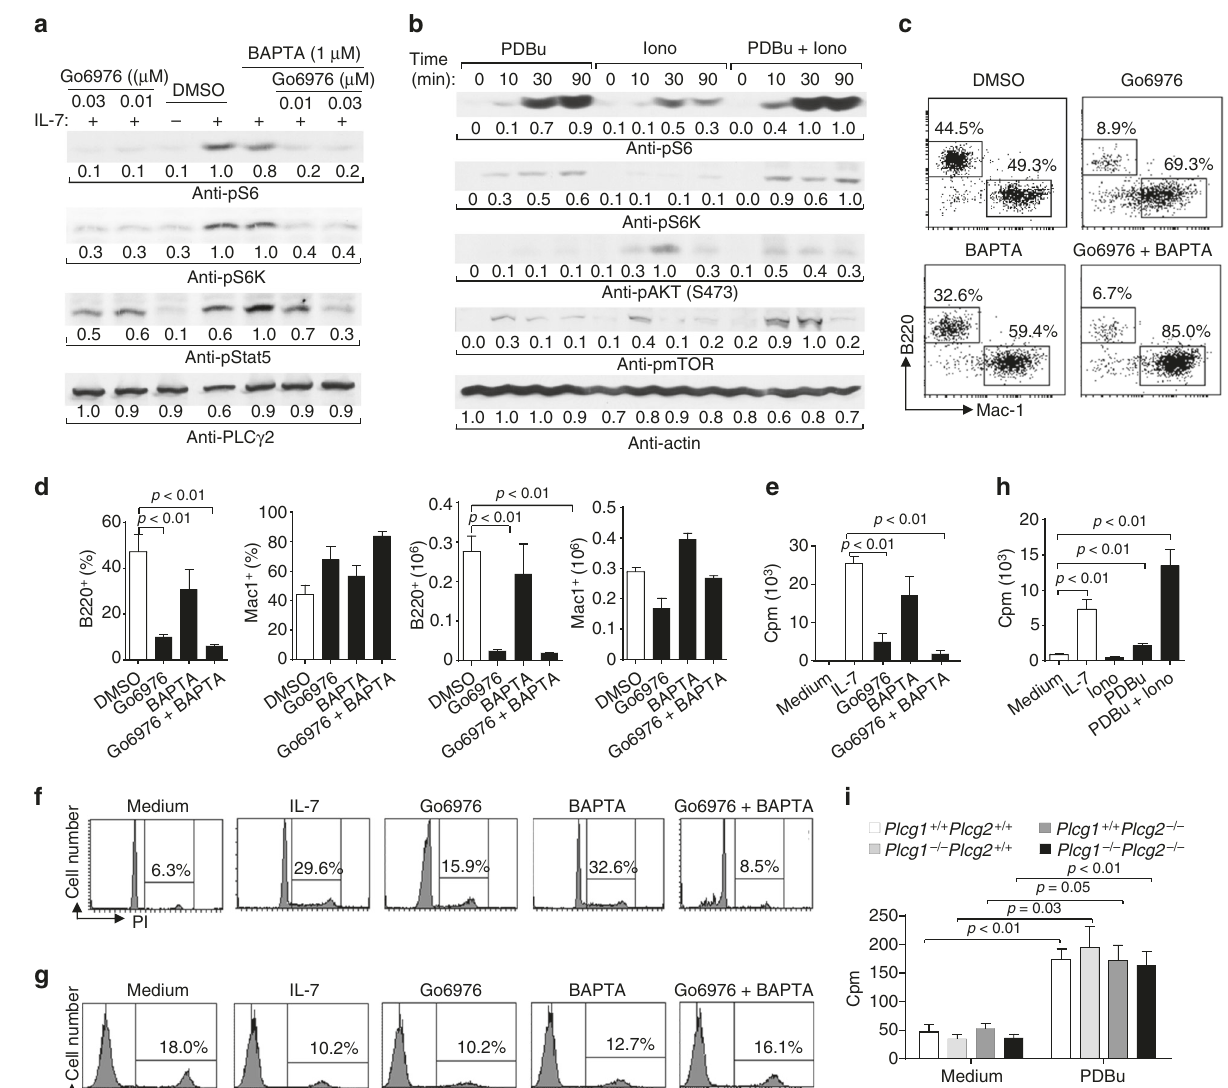
Fig. 7 A major role of the DAG/PKC-dependent pathway in IL-7-mediated mTOR activation and functions. a Inhibition of the PKC pathway impairs IL-7- induced mTOR activation. Pro-B cells derived from Rag1-de fi cient BM were pre-treated with DMSO, Go6976, BAPTA, or Go6976 plus BAPTA, and stimulated with IL-7. Cell lysates were subjected to western blot analysis. b The PKC pathway activates mTOR in pro-B cells. Pro-B cells derived from Rag1- de fi cient BM were starved and stimulated with PDBu, ionomycin, or both. Cell lysates were subjected to western blot analysis. c , d Inhibition of the PKC pathway impairs IL-7-dependent B cell production. Lin − BM cells from wild-type mice were cultured on OP9 cells plus IL-7 for 1 day and then were treated with DMSO, Go6976, or Go6976 plus BAPTA. Numbers indicate percentages of B220 + and Mac-1 + cells in the gated live cells ( c ). Bar graphs show the percentages and numbers of B220 + and Mac-1 + cells ( d ). e – g Inhibition of the PKC pathway impairs IL-7-mediated B cell progenitor proliferation but not survival. Pro-B cells derived from Rag1-de fi cient BM were cultured without IL-7 (medium) or with IL-7 plus DMSO, Go6976 or Go6976, and BAPTA. Cell proliferation was determined by [ 3 H] thymidine incorporation ( e ), cell-cycle analysis was performed by PI staining ( f ), and cell survival was measured by TUNEL staining ( g ). h PKC pathway activation induces B cell progenitor proliferation. Pro-B cells derived from Rag1-de fi cient BM were cultured without IL-7 (medium) or with IL-7, ionomycin (Iono), PDBu, or PDBu plus iono. Cell proliferation was determined by [ 3 H] thymidine incorporation. i YFP + CD45.2 + B220 + CD43 + CD24 + B cell progenitors were sorted from the congenic wild-type CD45.1 + recipients received Plcg1 + / + Plcg2 + / + , Plcg1 − / − Plcg2 + / + , Plcg1 + / + Plcg2 − / − , or Plcg1 − / − Plcg2 − / − BM, and cultured with or without PDBu. Cell proliferation was determined by [ 3 H] thymidine incorporation. The number beneath each band in the western blot indicates the relative intensity of the corresponding band. Error bars show ± SEM. Data shown are obtained from or representative of 3 ( a – d , f , g ), 4 ( i ), and 6 ( e , h ) independent To further demonstrate that the PLC γ pathway regulates treatment (Fig. 6e). Of note, U73122 pre-treatment had no effect mTOR activation by IL-7 stimulation, we examined the effect of on IL-7-induced phosphorylation of Stat5 in these B cell inhibition of this pathway on IL-7-induced activation of mTOR progenitors (Fig. 6e). As a control, CP-690550 reduced IL-7- in B cell progenitors without the pre-BCR. Pro-B cells were induced phosphorylation of S6, S6K, and Stat5 in these B cell derived from Rag1 -de fi cient BM cells. Pre-treatment of these progenitors (Fig. 6f). In addition, manoalide reduced IL-7- progenitors with U73122 reduced IL-7-induced phosphorylation induced phosphorylation of S6 compared to the control without of S6 and S6K compared with the control without inhibitor pre- inhibitor pre-treatment (Supplementary Fig. 10a). In contrast,